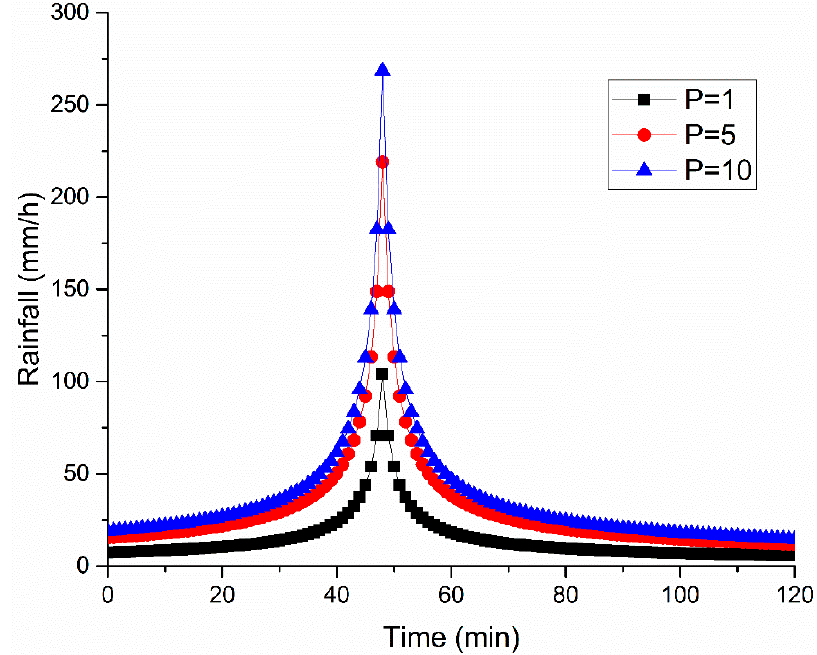
Figure 5. Rainfall processes used in the simulations.